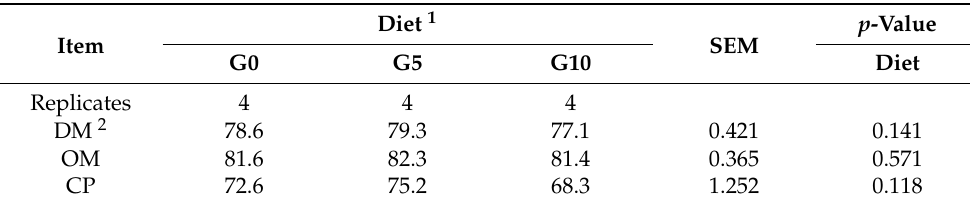
Table 4. Effects of glycerin addition to feed on apparent total tract digestibility of nutrients in Iberian crossbred